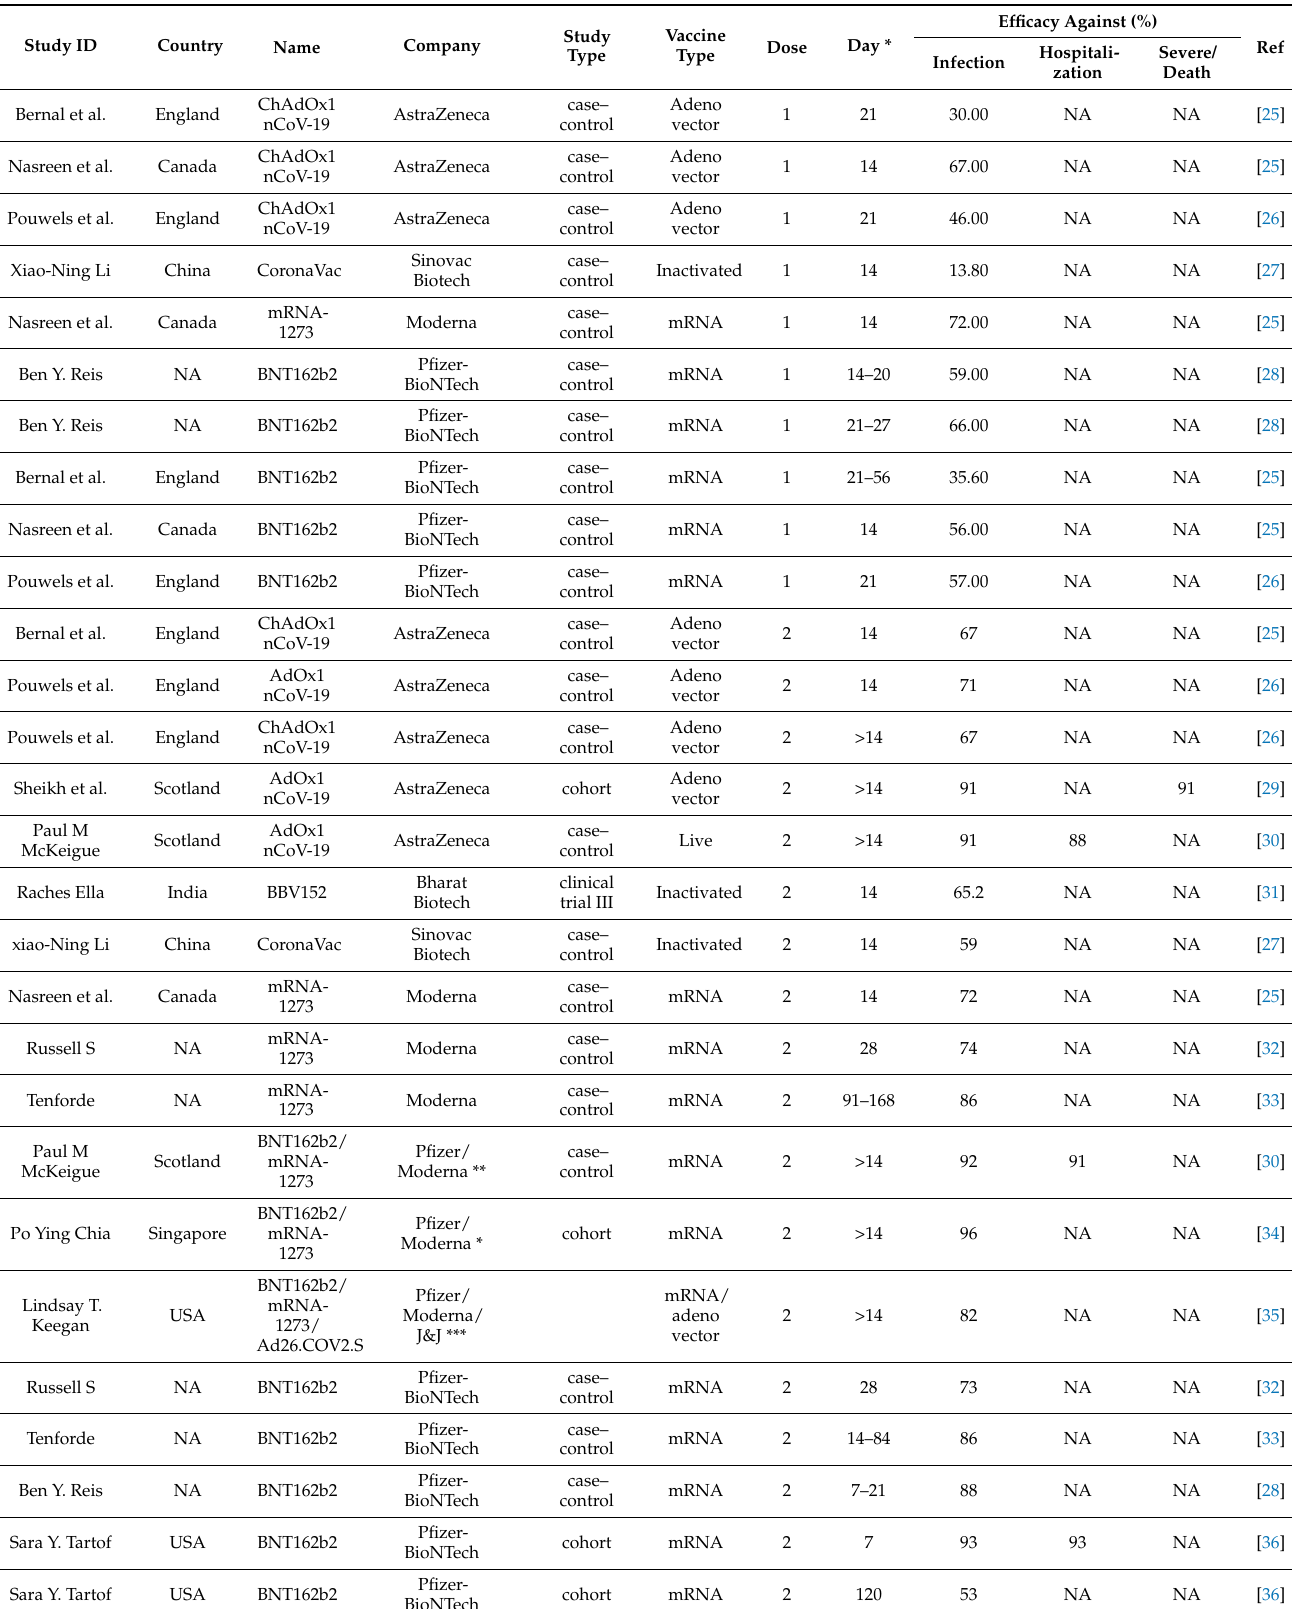
Table 1. Characteristics of included